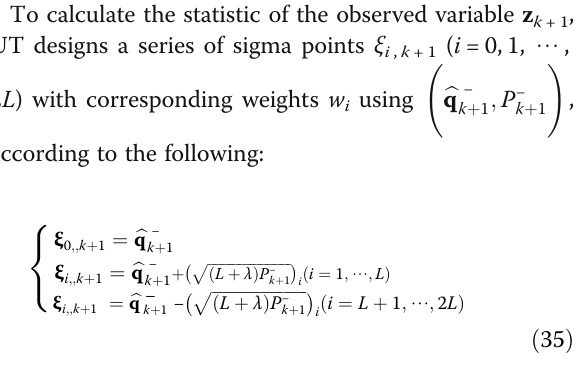
ffiffiffiffiffiffiffiffiffiffiffiffiffiffiffiffiffiffiffiffiffiffiffiffi L þ λ